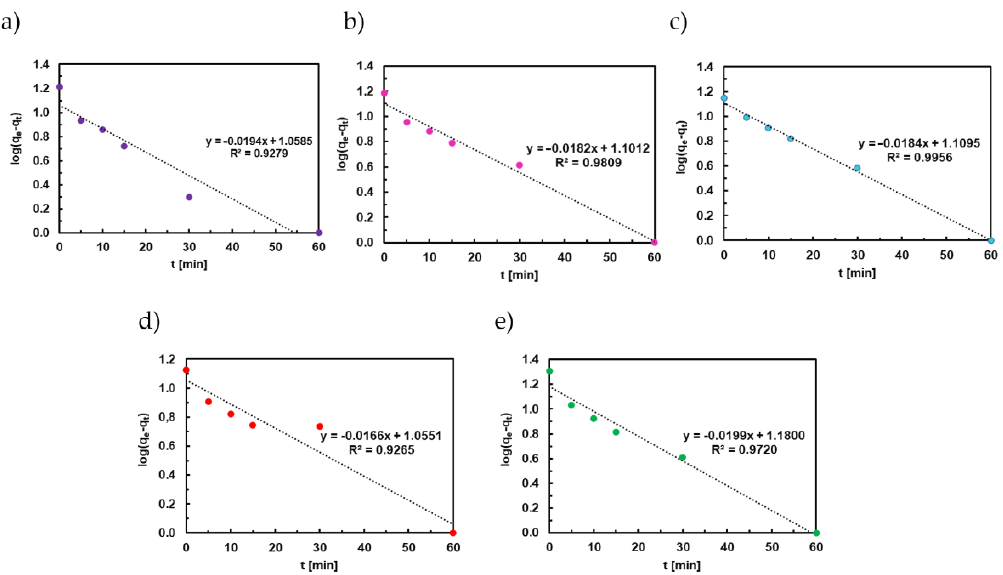
Figure 9. Adsorption data modeled using kinetic Lagergren’s pseudo-first-order law for ( a ) Fe 3 O 4 , ( b ) Fe 3 O 4 @1%Zn, ( c ) Fe 3 O 4 @2%Zn, ( d ) Fe 3 O 4 @5%Zn, and ( e ) Fe 3 O 4 @10%Zn nanoparticles.